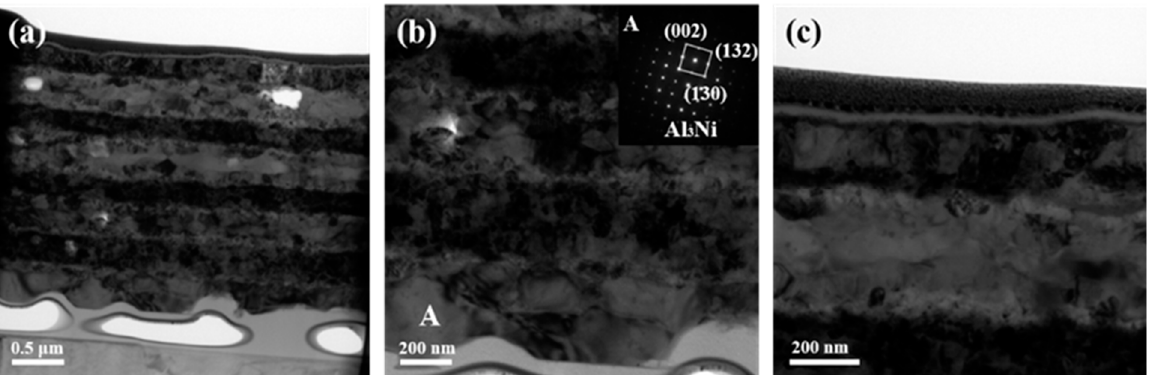
Figure 6. TEM images together with selected area electron diffraction patterns of the ATNT foil after annealing at 673 K for 3 h: ( a ) the whole morphology; ( b ) the bottom region; ( c ) the top region.